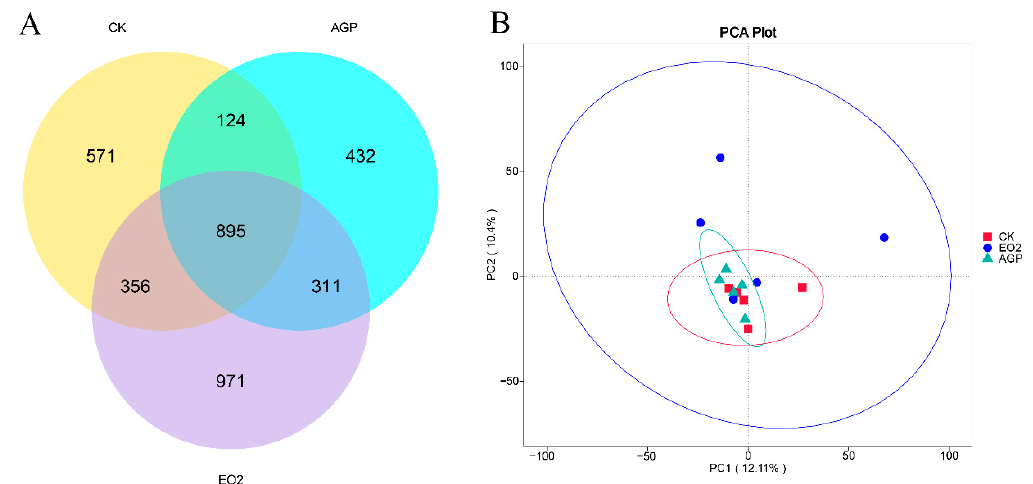
Figure 1. Venn diagram of ASV ( A ) and PCA ( B ) of cecum microbiota in the three groups. Control, hens received a basal diet; AGP, hens received a basal diet supplemented with 5 mg/kg flavomycin; EO2, hens received a basal diet supplemented with 200 mg/kg oregano essential oil and 20 mg/kg cinnamaldehyde.